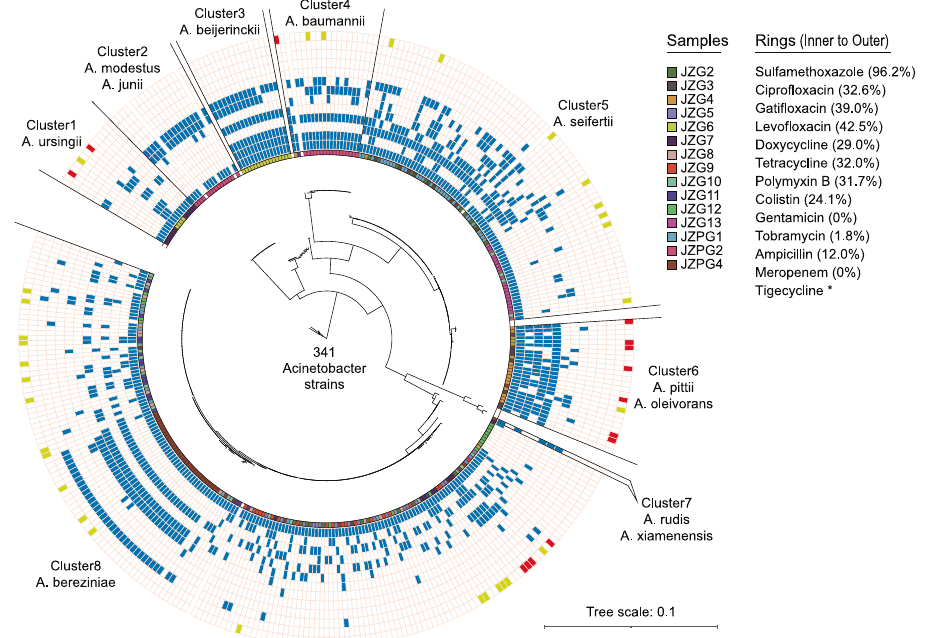
Fig. 6 The phylogenetic relationship of Acinetobacter strains with the antibiotic resistance phenotype. The strains are clustered into eight groups using 16S rRNA gene sequences with 99% similarity and 95% coverage. Rings represent samples as well as resistance pro fi les to sulfamethoxazole, cipro fl oxacin, gati fl oxacin, levo fl oxacin, doxycycline, tetracycline, polymyxin B, colistin, gentamicin, tobramycin, ampicillin, meropenem and tigecycline from the innermost to the outermost. Percentages in brackets are resistance ratios. Blue represents resistance, while yellow means MIC = 0.5 μ g/mL of tigecycline, and red means MIC = 1.0 μ g/mL of